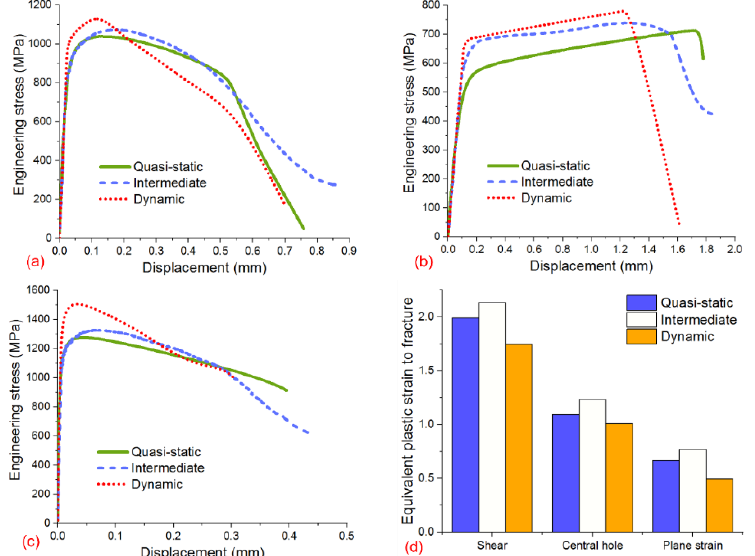
Fig. 3. Engineering stress-displacement plots of (a) central hole (b) shear and (c) plane strain specimens at quasi-static, intermediate and dynamic test speeds. (d) Influence of stress state and strain rate on fracture